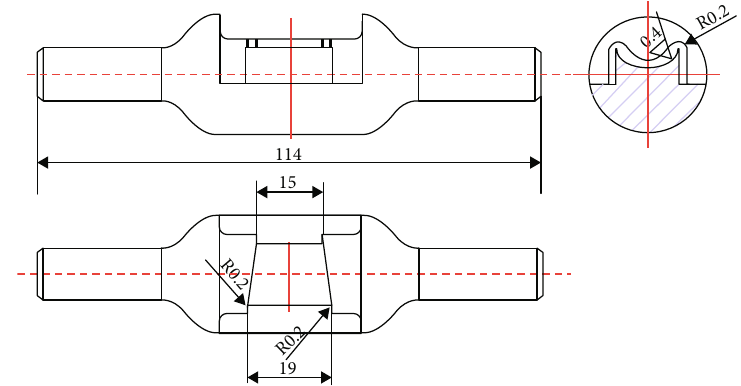
Figure 8: Using 702 to machine the pressure side in immersion oil.